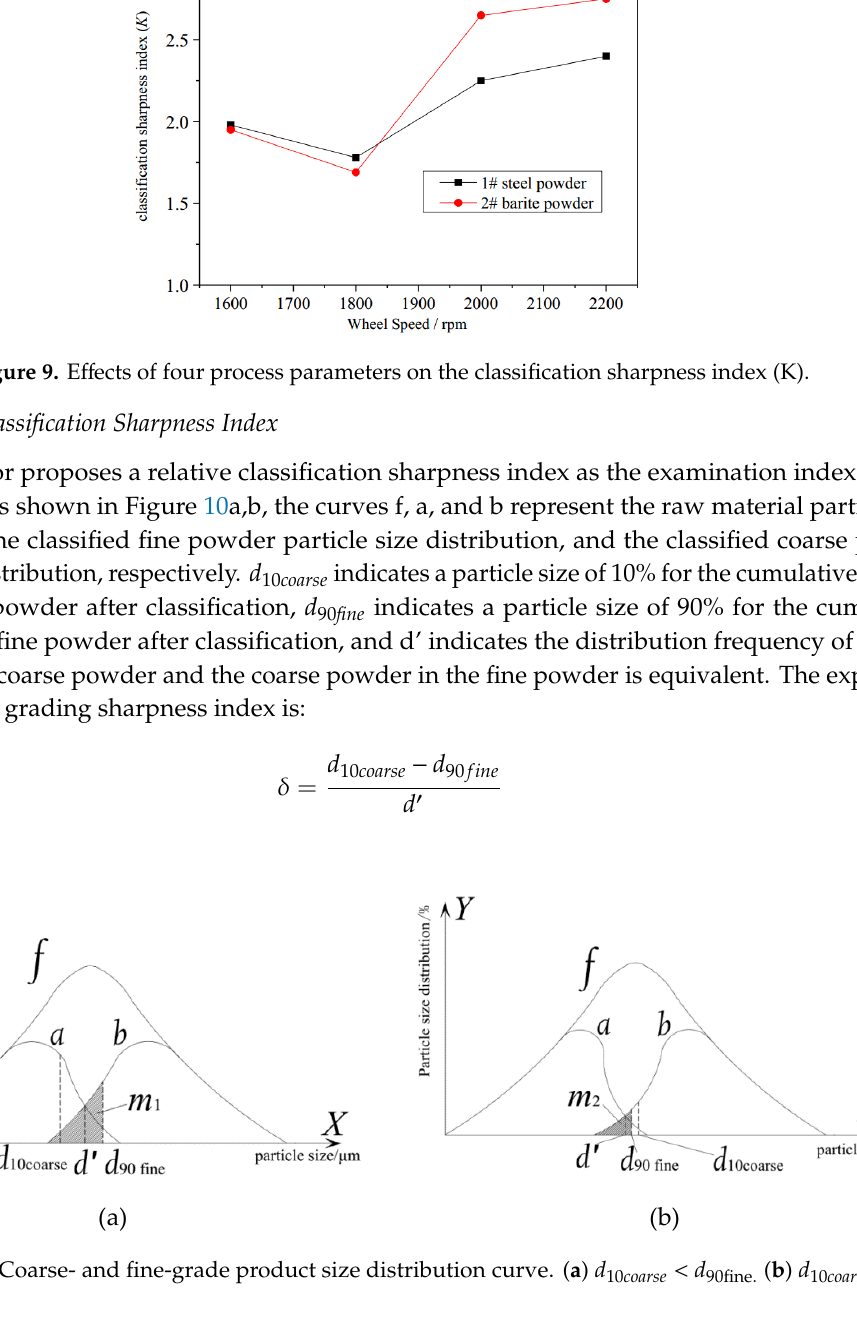
Figure 9. Effects of four process parameters on the classification sharpness index (K).